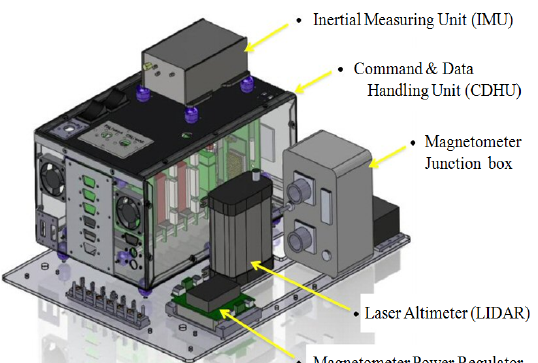
Figure 5. SIERRA Common Payload Data System (CPDS) for Surprise Valley Mission.